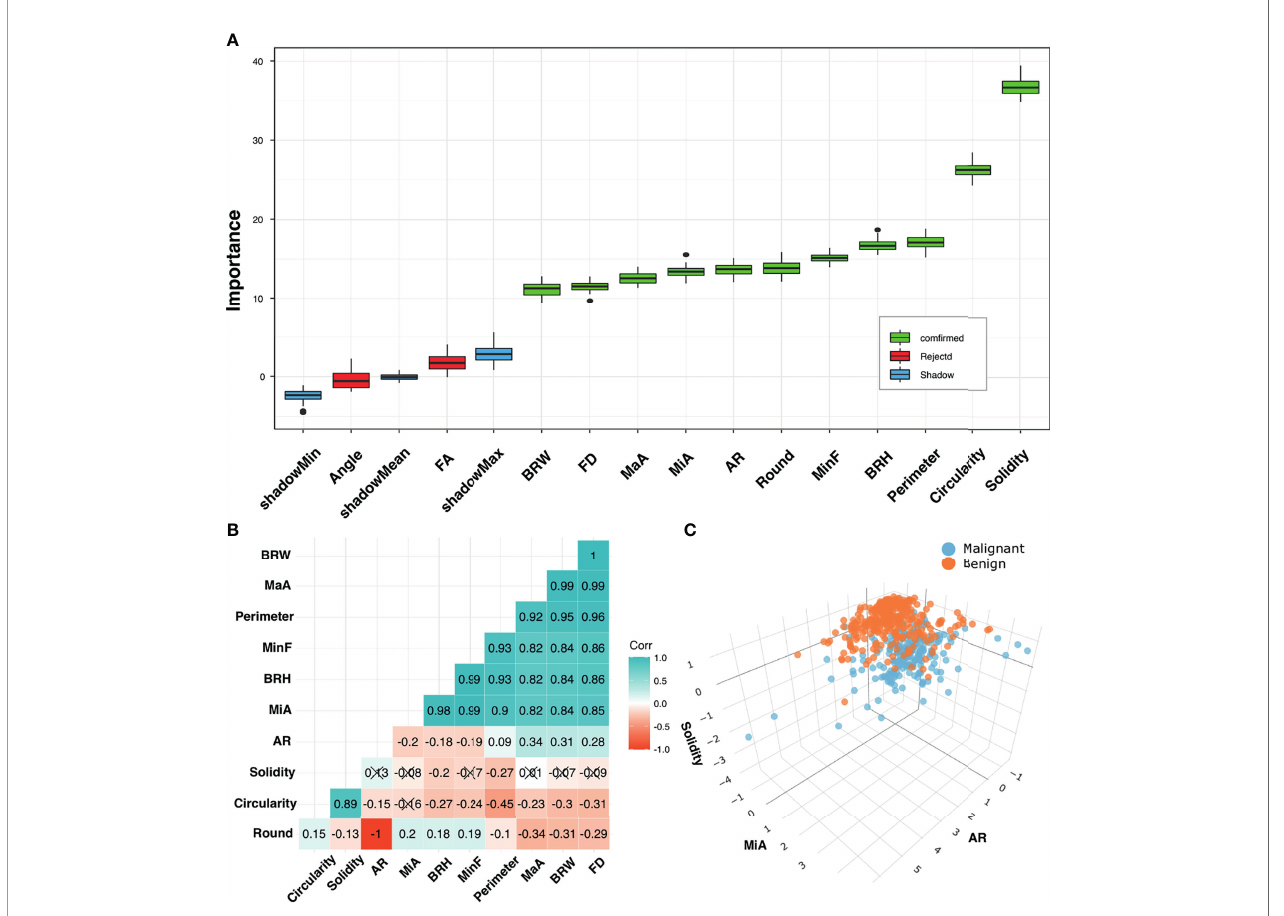
FIGURE 4 | Feature selection. (A) Selection of relevant morphometric features for discrimination between benign and malignant groups in the training cohort using the Boruta algorithm. Boxplots of features were sorted by increasing importance according to Z-scores. Blue boxes (Shadow) correspond to minimal, mean, and maximal importance, calculated from randomly permuted features. (B) Correlation matrix plot shows pairwise positively stronger correlations (blue) or negatively stronger correlations (red). Non-signi fi cant correlations (p > 0.05) are marked with a cross. (C) 3D scatter plots for fi nal selected feature combinations displaying separations of benign and malignant